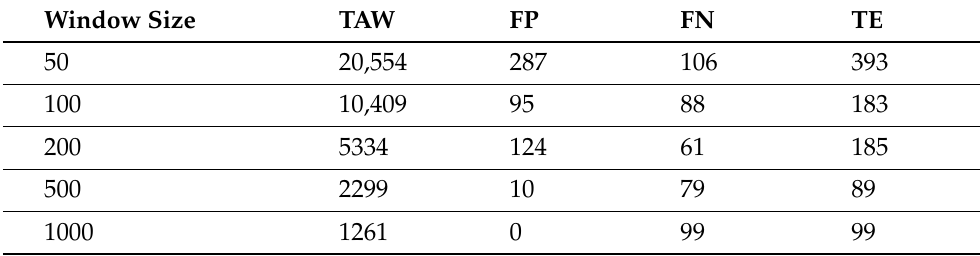
Table 6. Total error (DoS attack).